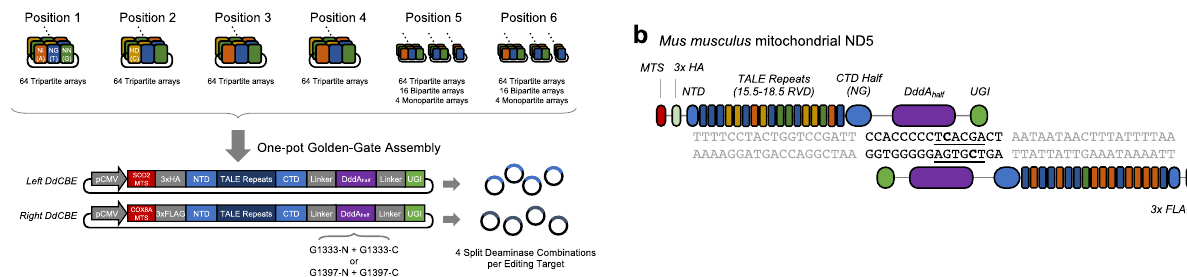
Fig. 1 Schematic illustration for assembling DdCBE and its mitochondrial DNA editing. a Scheme of one-pot Golden-Gate assembly for ef fi cient DdCBE construction. A total of 424 arrays (64 tripartite arrays × 6 + 16 bipartite arrays × 2 + 4 monopartite arrays × 2) and expression vector were mixed to generate left and right modules for the fi nal plasmid constructs. b Illustration of DdCBE interacting with mouse mitochondrial DNA target ND5 . TALE- binding regions are shown in gray and base editing windows are depicted in black. Different repeat variable diresidue modules are shown in orange, blue, green, and yellow, which represent “ NI ” for adenine, “ NG ” for thymine, “ NN ” for guanine, and “ HD ” for cytosine recognition,